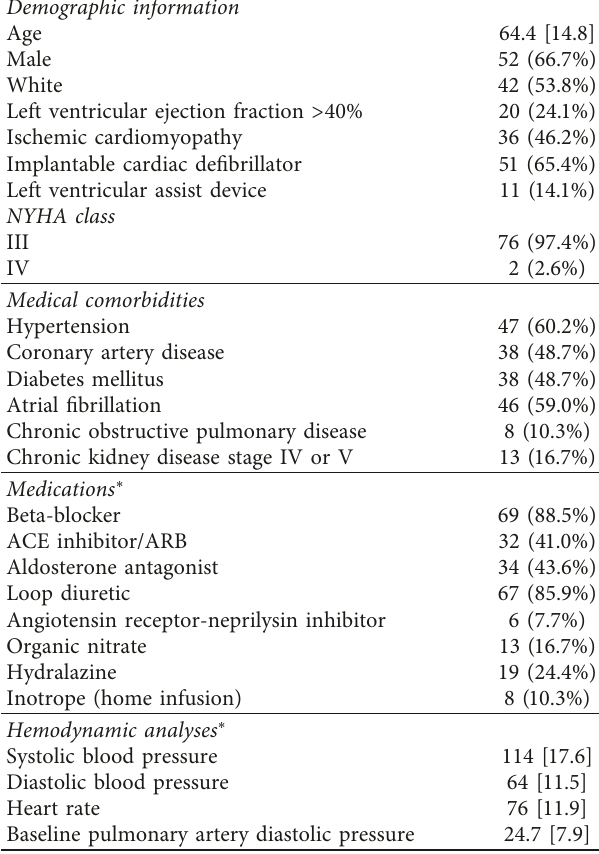
Table 1: Baseline descriptive characteristics.